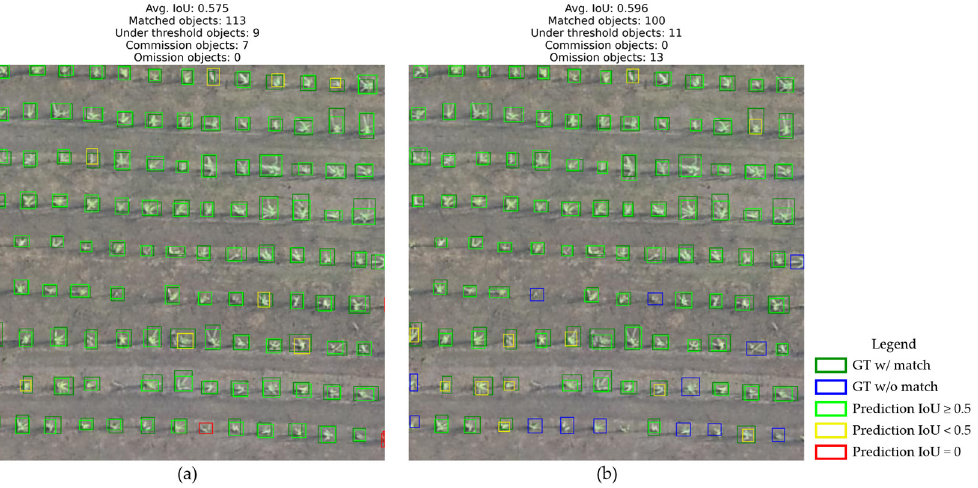
Figure 13. Example of visualized detection results of ( a ) EfficientDet-D0 and ( b ) Faster R-CNN.